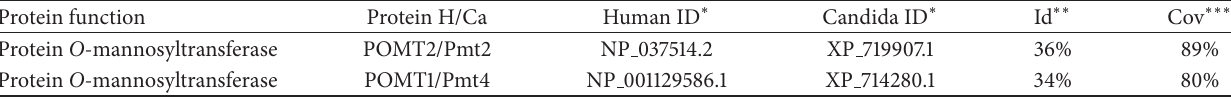
Table 3: Human and C. albicans homolog proteins involved in the O- mannosylation pathway.